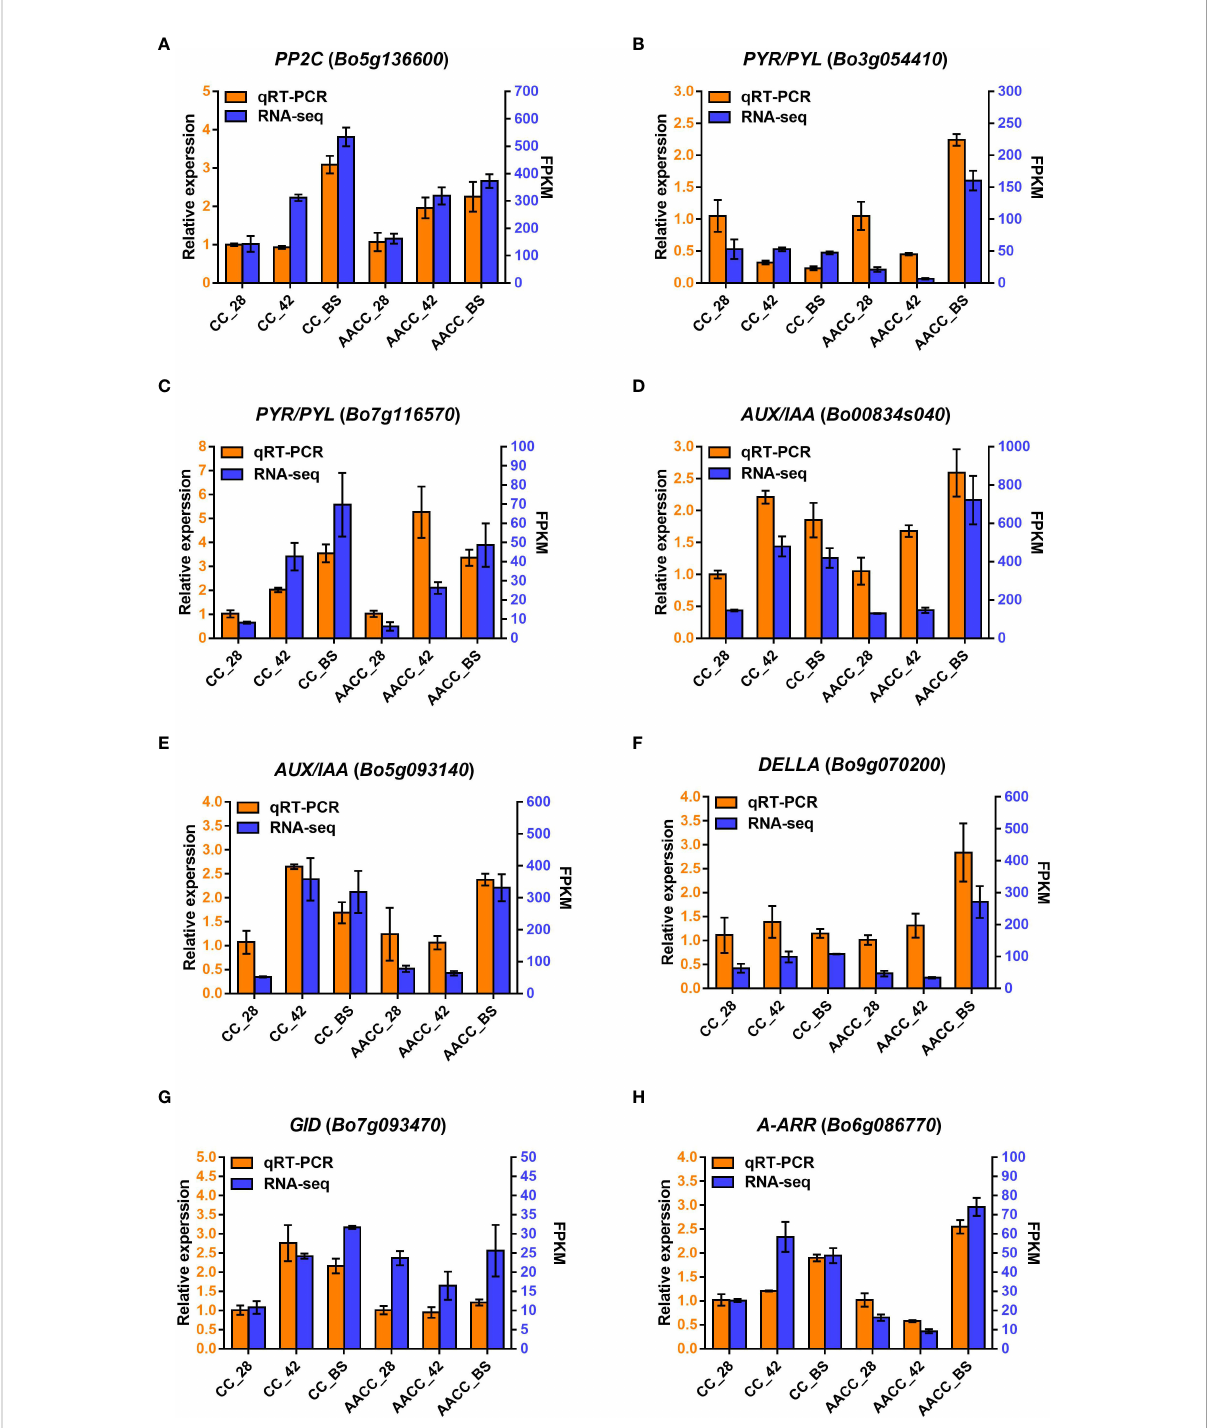
FIGURE 6 Quantitative real-time PCR (qRT-PCR) con fi rmation of eight candidate genes at the three stages including 28 DAS, 42 DAS and bolting stage between Chinese kale (CC) and allotetraploid (AACC). (A-H) The genes expression of PP2C ( Bo5g136600 ), PYR/PYL ( Bo3g054410 and Bo7g116570 ), AUX / IAA ( Bo00834s040 and Bo5g093140 ), DELLA ( Bo9g070200 ), GID ( Bo7g093470 ) and A - ARR ( Bo6g086770 ) veri fi ed by qRT- PCR, respectively. Left and right Y-axes indicate relative gene-expression levels determined by qRT-PCR and the FPKM obtained by RNA-seq, respectively. The results for each gene are based on three biological and three technical replicates. The error bars indicate standard